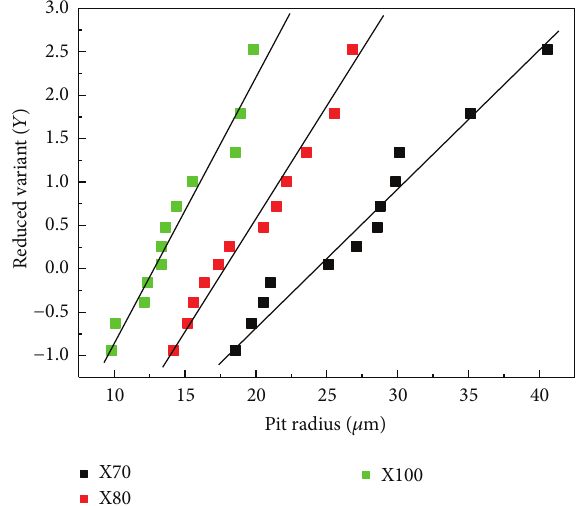
Figure 12: Gumbel probability plots of passive films for X70, X80, and X100 pipeline